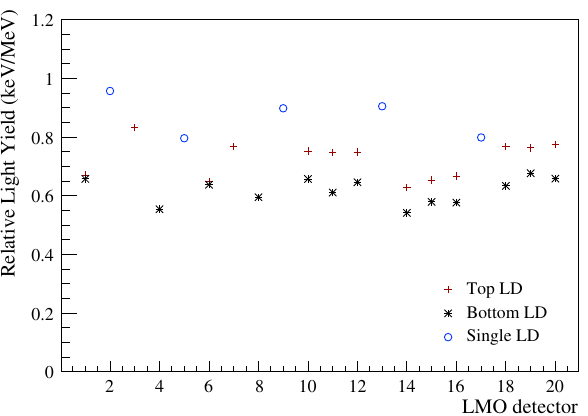
Fig. 14 Relative Light Yields for all of the Li 2100 MoO 4 crystals. The differences in RLY trace the expected light collection efficiencies due to the design of the towers, see Sects. 2.5 and